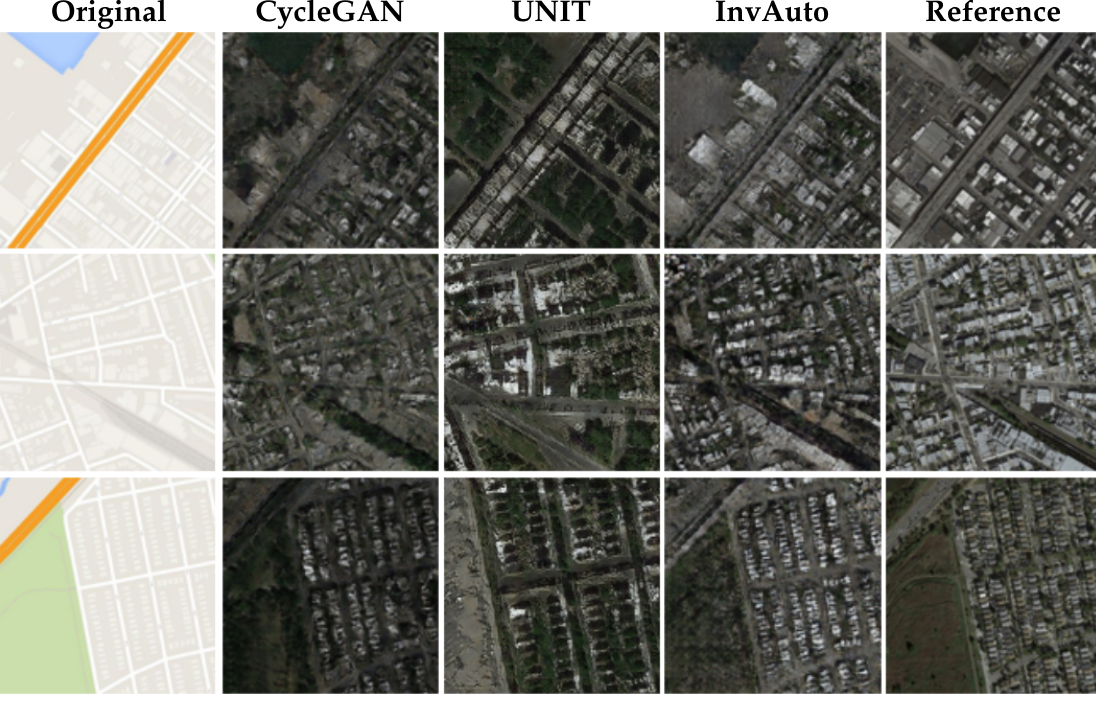
Figure A9. Maps-to-satellite image conversion.